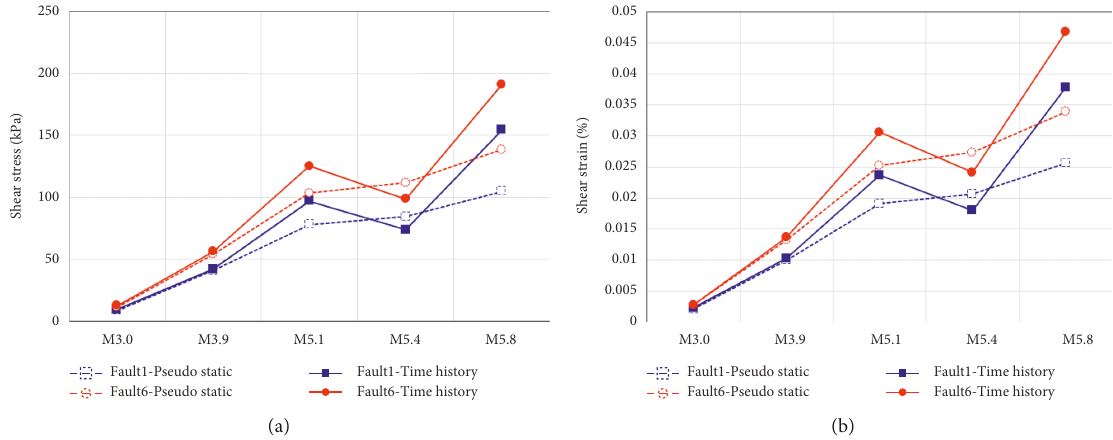
Figure 12: (a) Maximum shear stress and (b) maximum shear strain of two fault gouges (no. 1 (blue) and no. 6 (red)) for each earthquake magnitude via pseudostatic (dashed lines) and time-history (solid lines) analyses. The maximum shear stress and strain both increase as the magnitude increases during the pseudostatic analysis. However, the maximum shear stress and strain for the M5.4 earthquake are lower than those for the M5.1 earthquake.